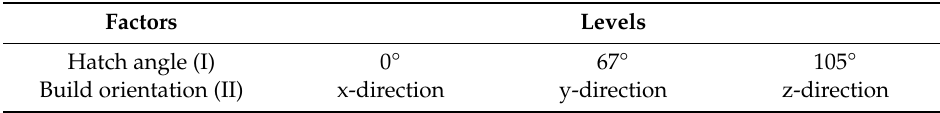
Table 4. Full-factorial